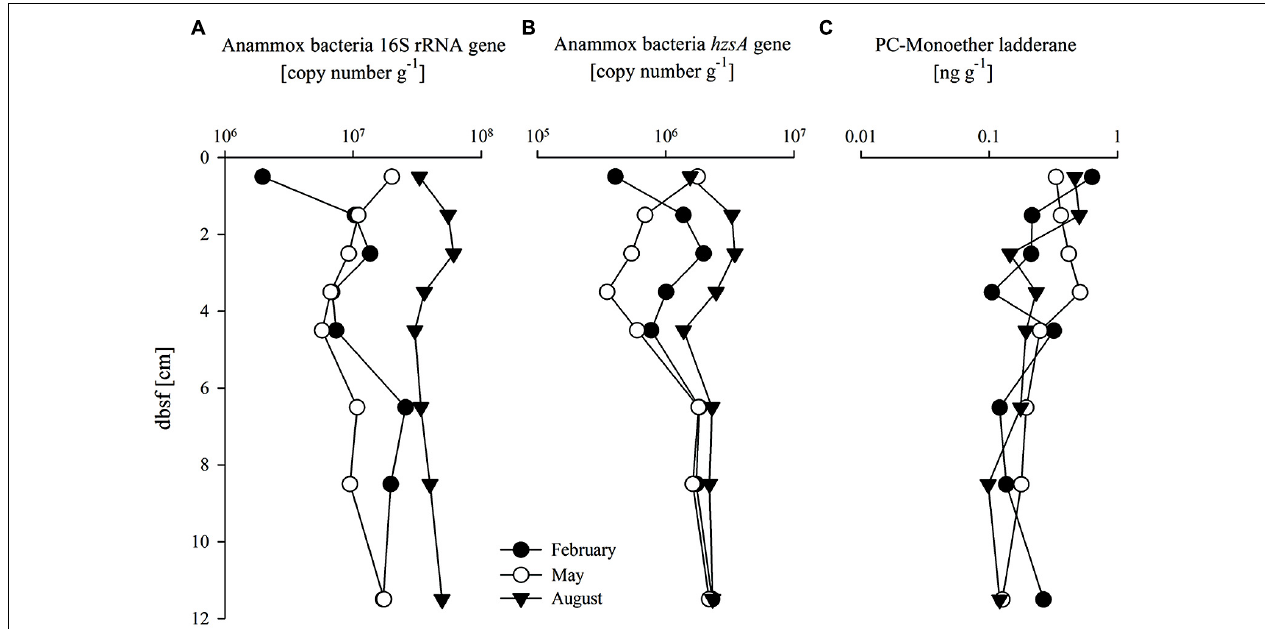
FIGURE 4 |Abundance of (A)Anammox bacteria 16S rRNA gene (copy number g − 1 ); (B)Anammox bacteria hzs A gene (copy number g − 1 ), and (C) PC-monoether ladderane (ng g − 1 ) with sediment depth (cm) below sea floor